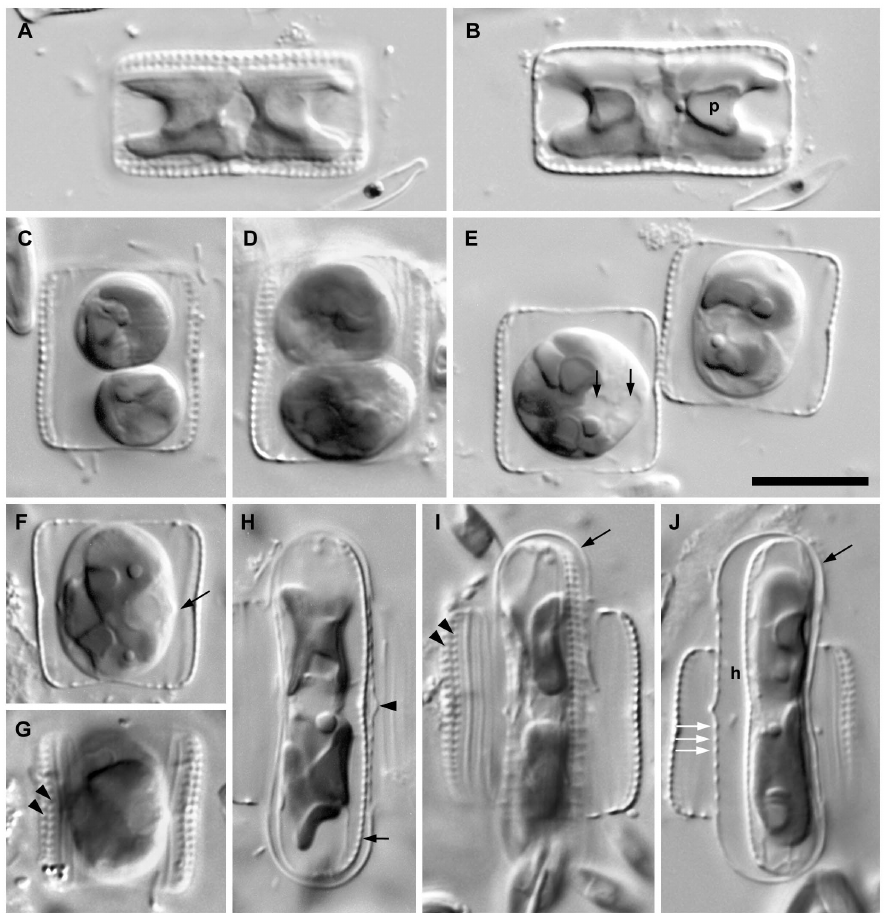
Figure 7. Vegetative cells and auxosporulation in Biremis sp. A, B. Two focuses of a vegetative cell in girdle view. Each cell contains two chloroplasts either side of the centre, each of which comprises two plates (one is shown for each chloroplast in Fig. 7A, the other being out of focus beneath, on the opposite side of the cell) connected by a narrow bridge containing the pyrenoid (e.g. p). C, D. Two paired gametangia, each containing two rounded, rearranged gametes. The gametangia were paired with their girdles adjacent, the cell shown in Fig. 7D lying immediately below that in Fig. 7C. E . Two paired gametangia, unusual in being in contact only via their valves. Each gametangium contains a single subspherical zygote. Two nuclei are visible in the left-hand cell (arrows) and two of the four chloroplasts in the right-hand cell. F, G. Two focuses of a gametangium containing a zygote on the point of transformation into an auxospore. Note the slight central inflection of the zygote’s outline, marking the deposition of the primary transverse perizonial band (cf. Fig. 7H, arrowhead). The two rows of foramina on the valves can be seen in Fig. 2G (arrowheads). H . Expanded auxospore containing the initial epivalve (in section at arrow). The auxospore is encased in a well developed perizonium, containing a primary transverse band flanked by several secondary bands (see in section: see also Figs 7I, J). I. Peripheral focus of an expanded auxospore containing the initial epivalve. The two rows of foramina on one of the gametangium valves can be seen (arrowheads). The end of the auxospore is covered by a siliceous cap (arrow). J. Expanded auxospore containing a completed initial cell. The initial hypovalve (in section at h) lies at a distance from the perizonium, as a result of a strong contraction of the protoplast immediately before its formation; the initial epivalve lies opposite, directly moulded by the interior of the perizonium. The auxospore casing can be seen to consist of a perizonium of transverse bands (e.g. at white arrows) and two silicified hemispherical caps (e.g. at black arrow). [Scale bar 10 m